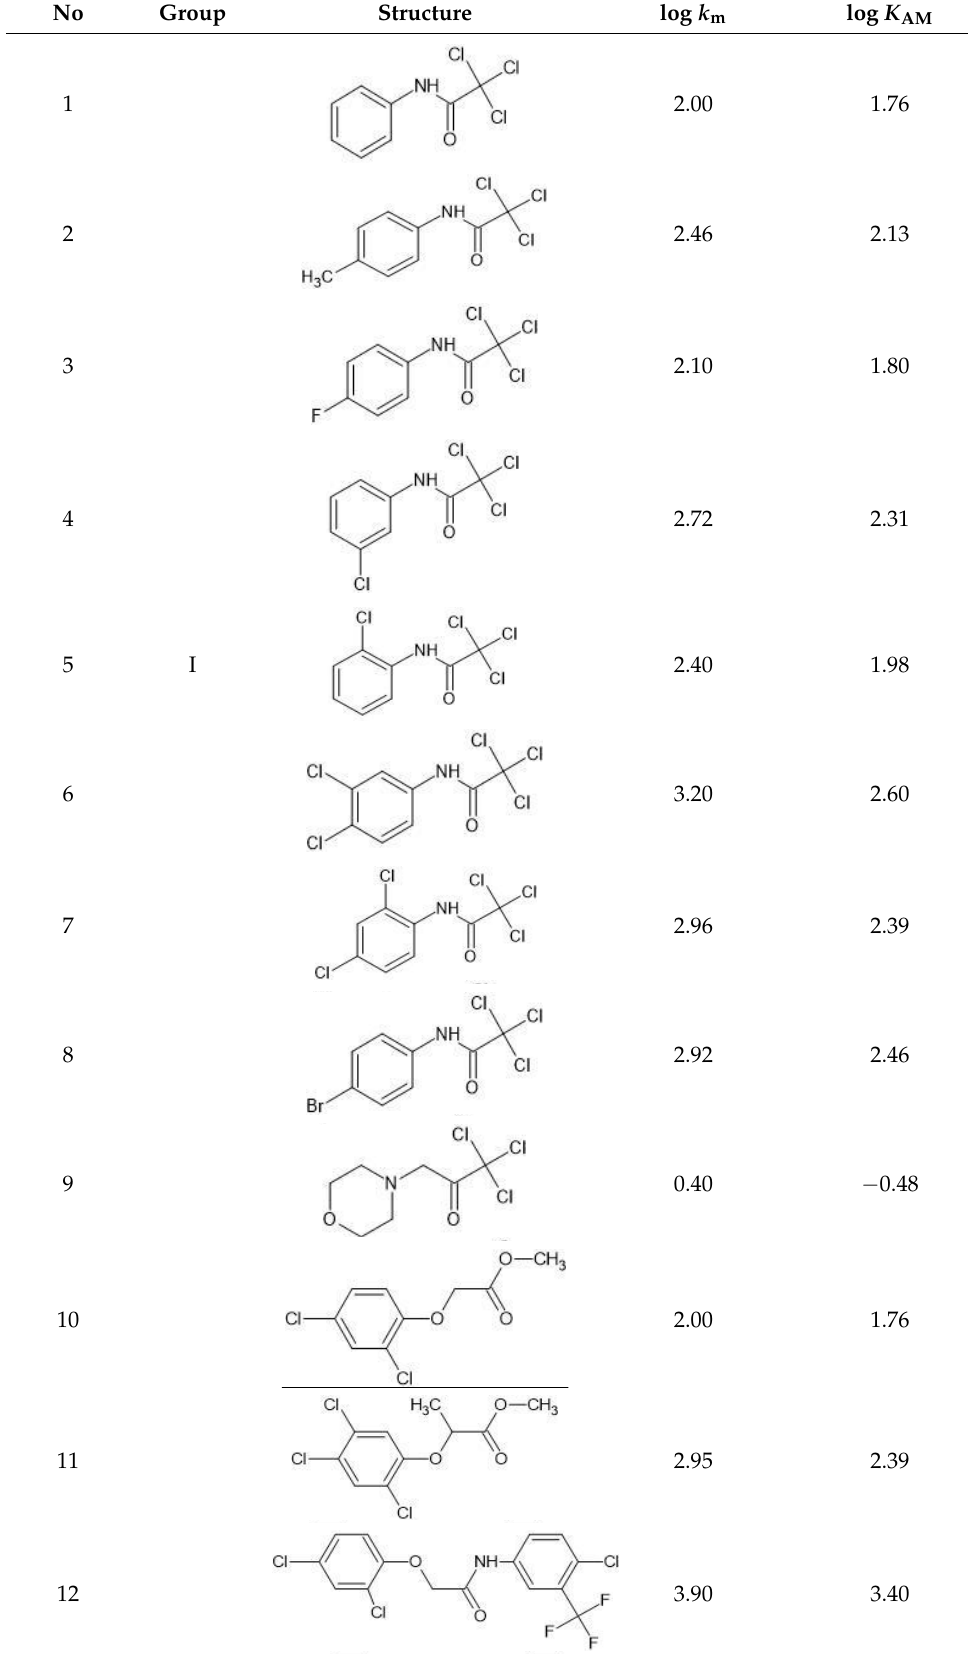
Table 1. Structures and chromatographic parameters [23] of tested compounds.